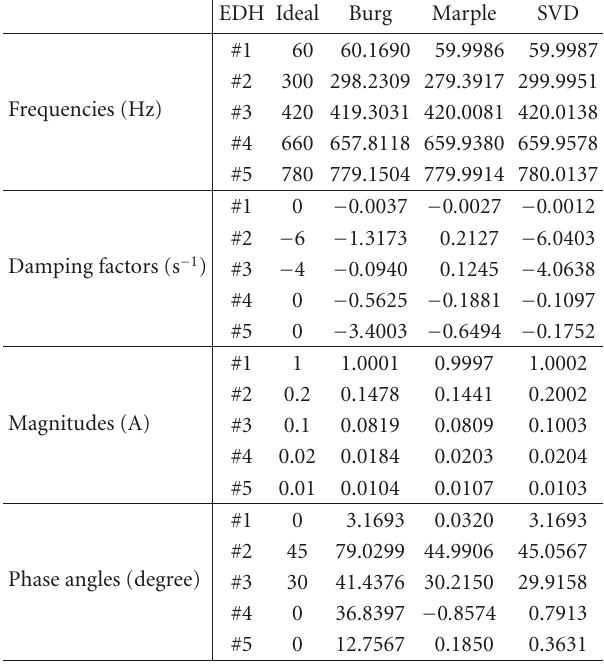
Table 1: Estimated dominant harmonics (EDH) on a nonstationary